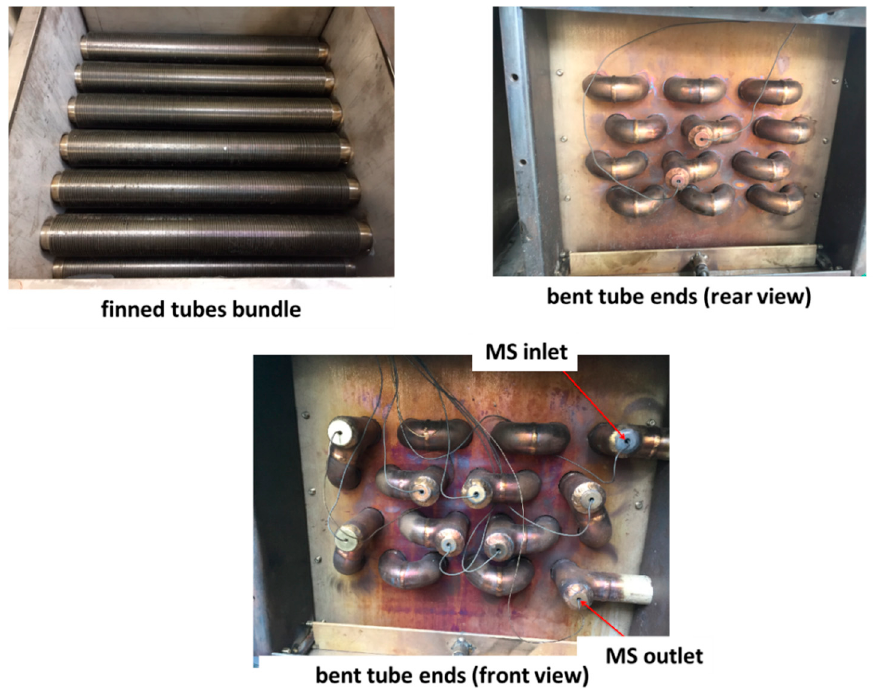
Figure 6. 3D drawings of the designed MSH mock up.